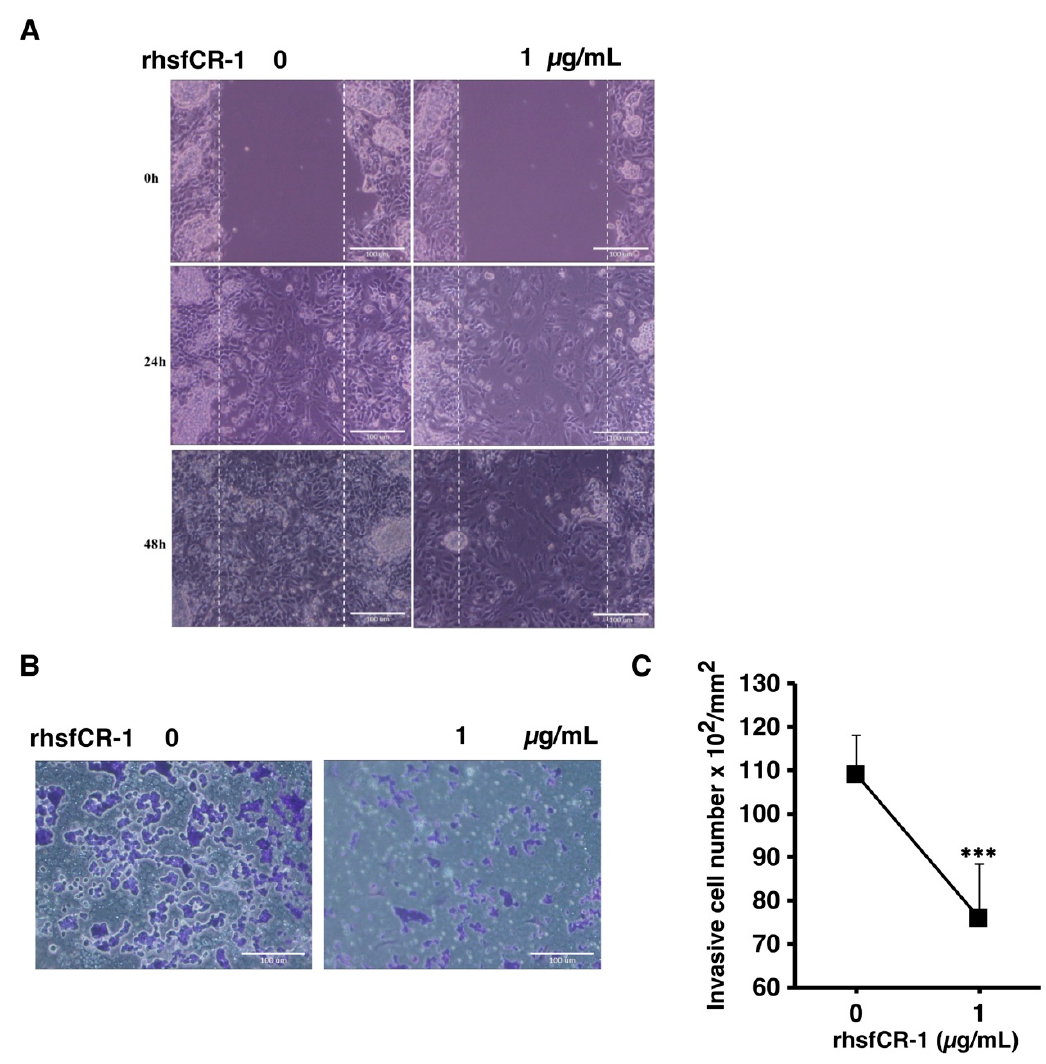
Figure 7. rhsfCR-1 suppressed migration and invasion in miPS-LLCcm cells. ( A ) Wound healing potential was assessed after the treatment without or with rhsfCR-1 (1 µg/mL) for 24 and 48 h; ( B ) invasion ability was assessed with using Matrigel-coated inserts. Invasive cells were stained with Giemsa; ( C ) the graph indicates the results of quantitative analysis of invasive cells stained with Giemsa. The number of stained cells was counted from several different (six) fields. The data were analyzed using two- tailed Student’s t -test and are presented as the mean ± SD. *** p < 0.001.